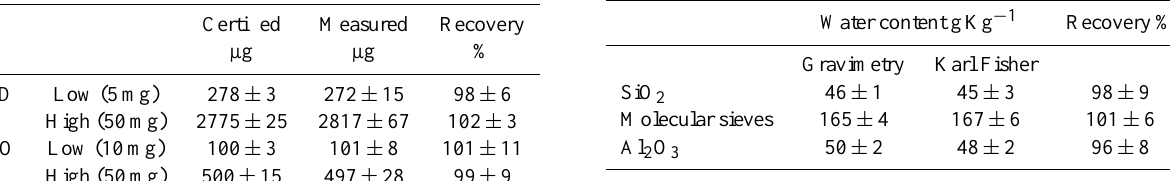
Table 2. Comparison of gravimetric and Karl Fisher determination of the water content. N =